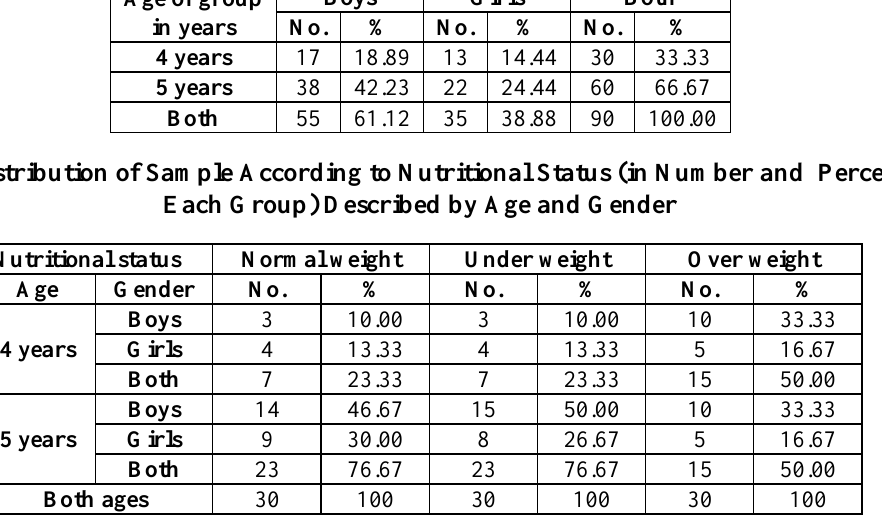
Table 3: Concentration of Measured Elements in Saliva According to Nutritional Status (Mean and Stander Deviation) and Differences between Them